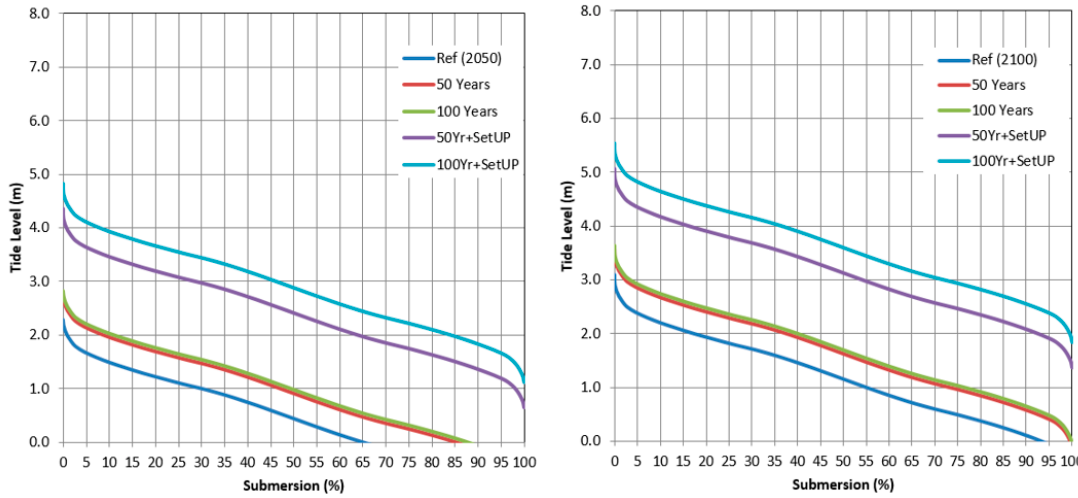
Figure 5. Cascais tide submersion percentile for the reference mean sea level (MSL) (blue) at epoch 2050 ( left ) and epoch 2100 ( right ), with additional storm surge for 50- and 100-year return periods (red and green) and wave setup (purple and light blue).